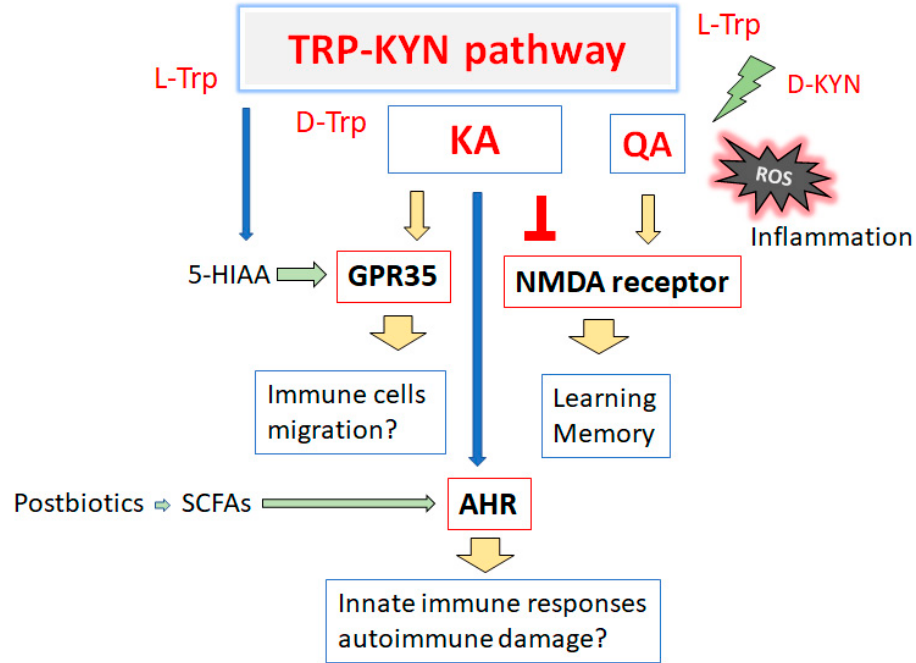
Figure 2. Schematic diagram for the biological effects of kynurenine metabolites from the tryptophan (TRP) and kynurenine (KYN) pathway. NMDA receptor, GPR35, and AHR might play key roles in the biological consequences. The arrowhead means stimulation and/or augmentation. Some critical events have been omitted for clarity. AHR: aryl hydrocarbon receptor; D-Trp: D-Tryptophan; L-Trp: L-Tryptophan; D-KYN: D-Kynurenine; L-KYN: L-Kynurenine; GPR35: G protein-coupled receptor 35; KA: Kynurenic acid; QA: Quinolinic acid; 5-HTP: 5-Hydroxytryptophan; 5-HT: 5-hydroxytryptamine (Serotonin); 5-HIAA: 5-Hydroxyindoleacetic acid; NMDA: N-methyl-D-aspartate; and SCFAs: short- chain fatty